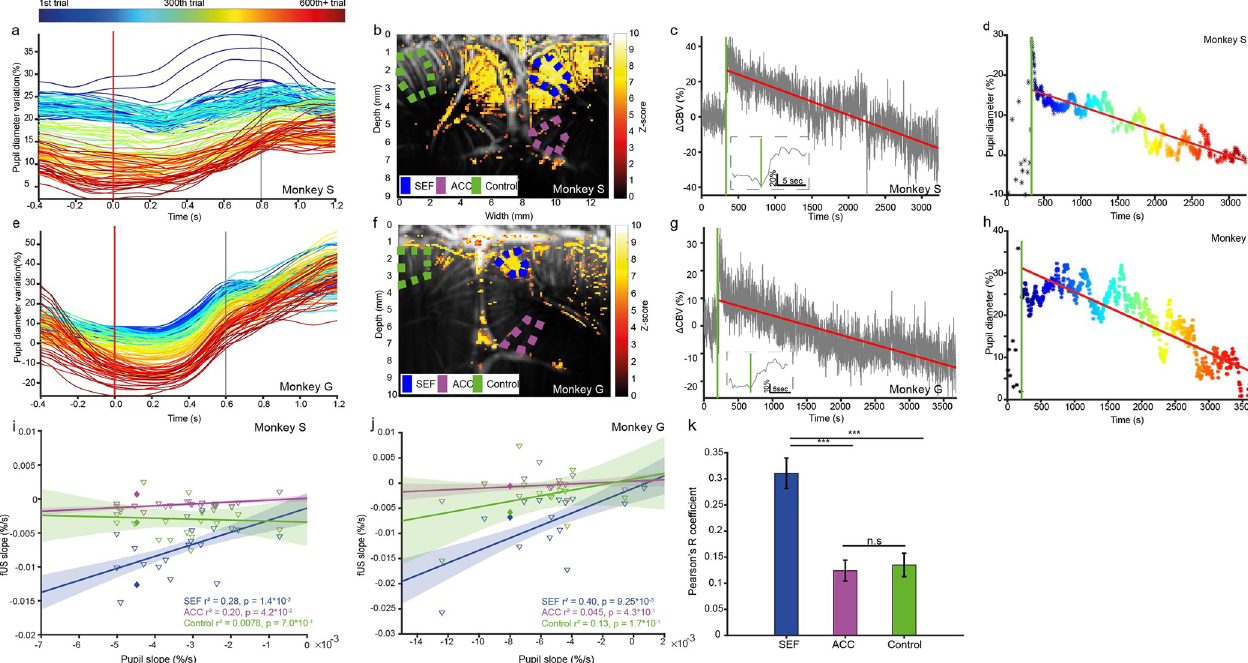
Fig 2. Example of 1 session for each monkey of the vascular and pupillary responses and multiple sessions covariation of pupillary and vascular responses. (a) Pupillary response over time. The color represents the number of the trial (blue: first trial, red: last trials), whereas the temporal abscissa represents the time prior to the presentation of the saccade or antisaccade cue. The vertical line represents the chosen time for the maximal dilation (0.8 s for Monkey S). (b) The vascular response of Monkey S using Fig 2D as an input matrix for the GLM. The background image consists of an anatomical image obtained by averaging all the Doppler films. The Z-score map was obtained using the GLM and thresholded using the Bonferroni correction ( p < 0.05 uncorrected). (c) Example of a CBV response during the starting of a task for Monkey S., showing a step at the end of the baseline and the beginning of the task. The small square represents a zoom on the first trial. (d) Maximum pupillary dilation at 0.8 s after presentation of the cue using the same color code as in B. Black stars represent the pupillary diameter during baseline. (e) Same as for 2.a for Monkey G. The vertical line is at 0.6 s after presentation of the cue. (f) Same as for 2.b for Monkey G, using 2.h as an input matrix. (g) Same as for 2.c for Monkey G. (h) Same as for 2.d for Monkey G. (i and j) Scatter plot of the Δ CBV slope in function of pupil slope in SEF (blue), ACC (purple) et Control area (green) for both Monkey S (Fig 2I), and Monkey G. (Fig 2J), prediction intervals are the 95% prediction interval. The session represented in full lozenge is the session taken as example in a–d for Monkey S and e–h for Monkey G. (k) Pearson’s correlation coefficient between pupil diameter (see d and h) and 3 areas in the brain: SEF (blue), ACC (purple), and Control (green) for all nonreward-modulated sessions for both animals ( n = 21 sessions for Monkey S, n = 13 sessions for Monkey G), ��� p < 0.001, ns: not significant. The data underlying the graphs shown in the figure can be found in https://osf.io/2q357/. All vertical green bars represent the end of the baseline and the start of the task. ACC, anterior cingulate cortex; CBV, cerebral blood volume; GLM, generalized linear model; SEF, supplementary eye field.